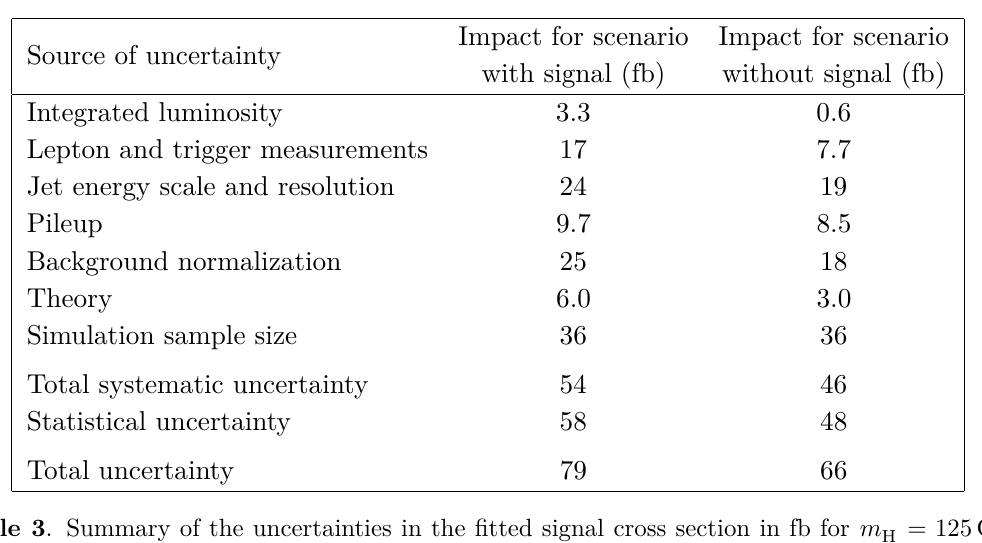
) and the absence of a signal ( σ = 0 SM